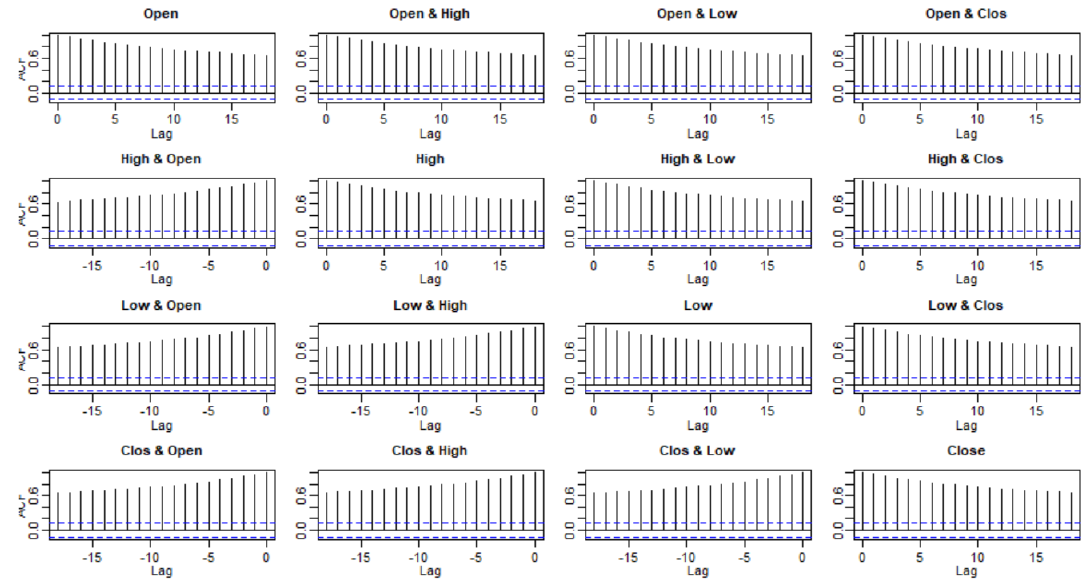
Figure A3. ACF test for correlation between open, low, high, and close of Google daily stock